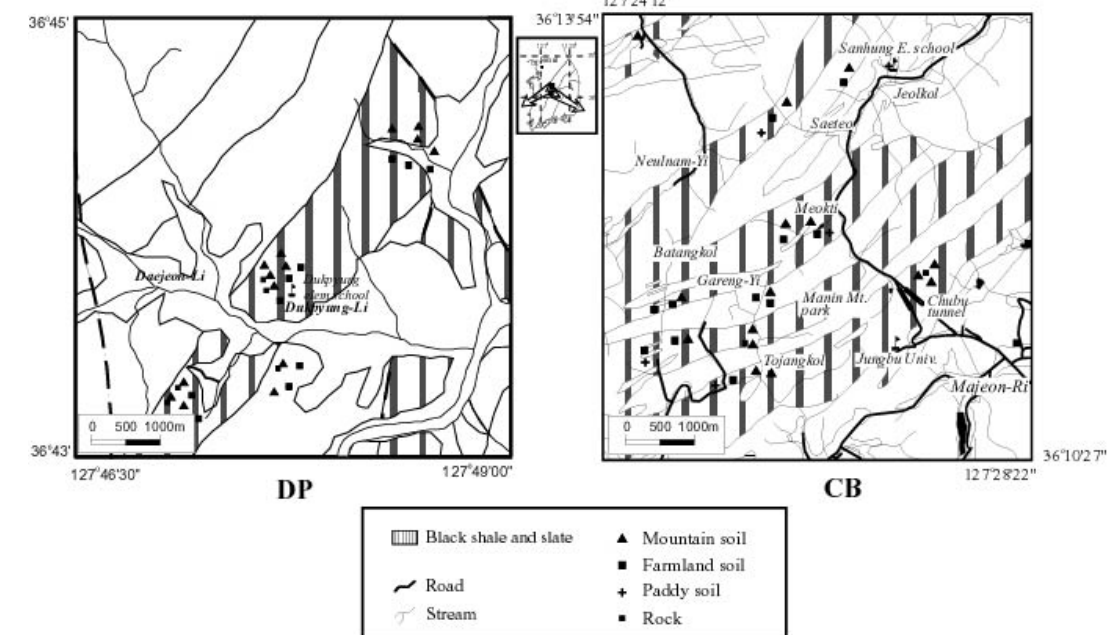
FIGURE 1 . Geologic map and sampling localities of in the Dukpyung (DP) and Chubu (CB) areas in the Okchon zone. Lined parts indicate either the Guryongsan (DP) and Changri Formation (CB) which mainly consist of black shales and slates. MATERIALS AND